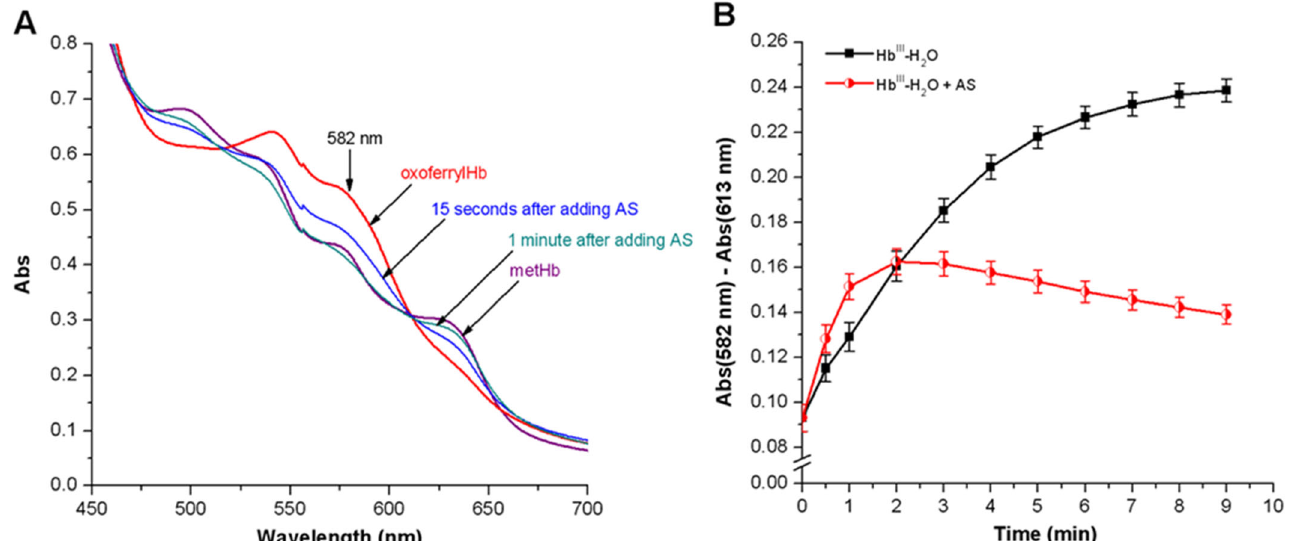
Figure 9. ( A ) Reduction of oxoferrylHb (Hb ‐ Fe IV = O) with Angeli’s salt. Reaction mixture: 0.03 mM Hb in 50 mM PBS (pH 7.4), 0.4 mM H 2 O 2 , 0.12 mM Angeli’s salt. Catalase (0.456 units) was added to remove unreacted H 2 O 2 ; ( B ) Effect of Angeli’s salt on formation of oxoferryl ‐ Hb in MetHb ‐ H 2 O reaction with t ‐ BOOH. Reaction mixture: 0.03 mM Hb in 50 mM PBS (pH 7.4), 0.71 mM t ‐ BOOH, 0.4 mM Angeli’s salt. Results are depicted as the mean with S.E.M. of three independent experiments ( n = 3). Student t ‐ test ( B ) ( p ≤ 0.05 for all point after 2.5 min).